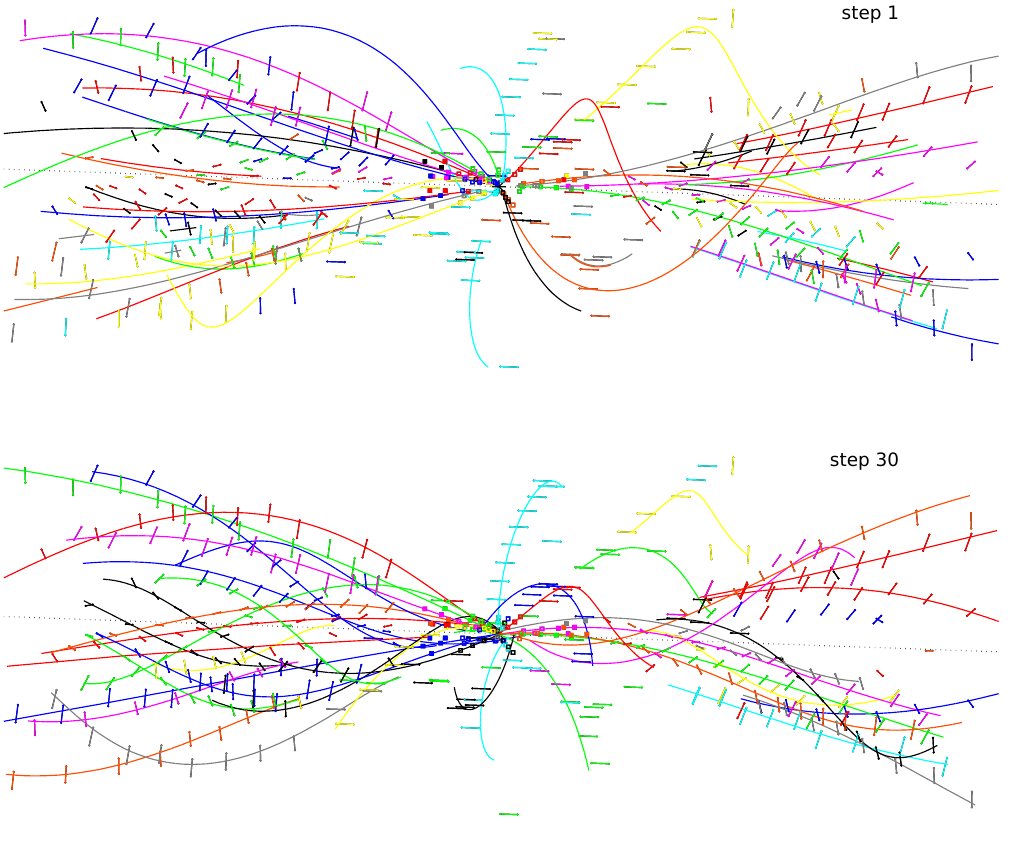
Figure 3. Hits and track candidates and their trajectories (colored curves), after the first iteration ( top ), and after the 30 th iteration (bottom) . The event is identical to the one displayed in Figure